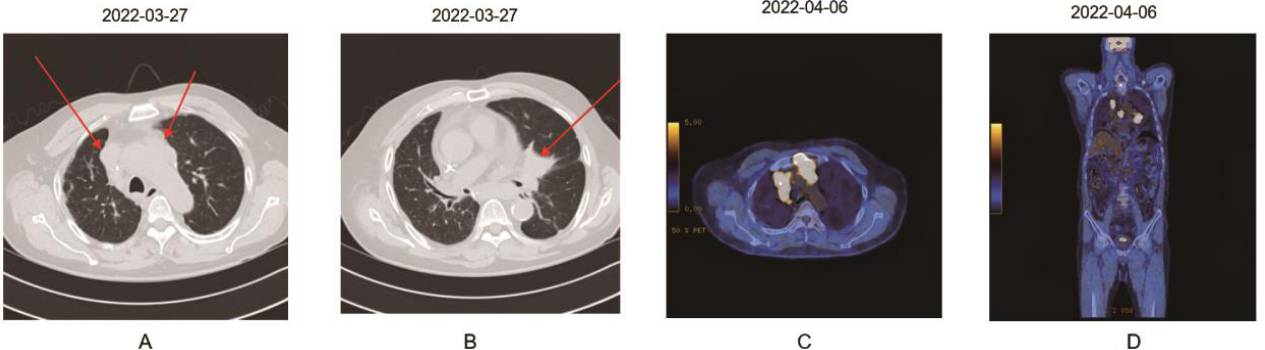
Figure 2. CT scan of the chest and [F-18]PET/CT scan on progression. ( A , B ) The CT scan of the chest on 22 March 2022 showed increased size of an increasing mass in central area of left upper lobe and enlarged LNs, as well as several new small nodules in both lungs. ( C , D ) The [F-18]PET/CT scan on 6 April 2022 showed [F-18]FDG uptake in metastatic nodules in the left and right upper lobes.